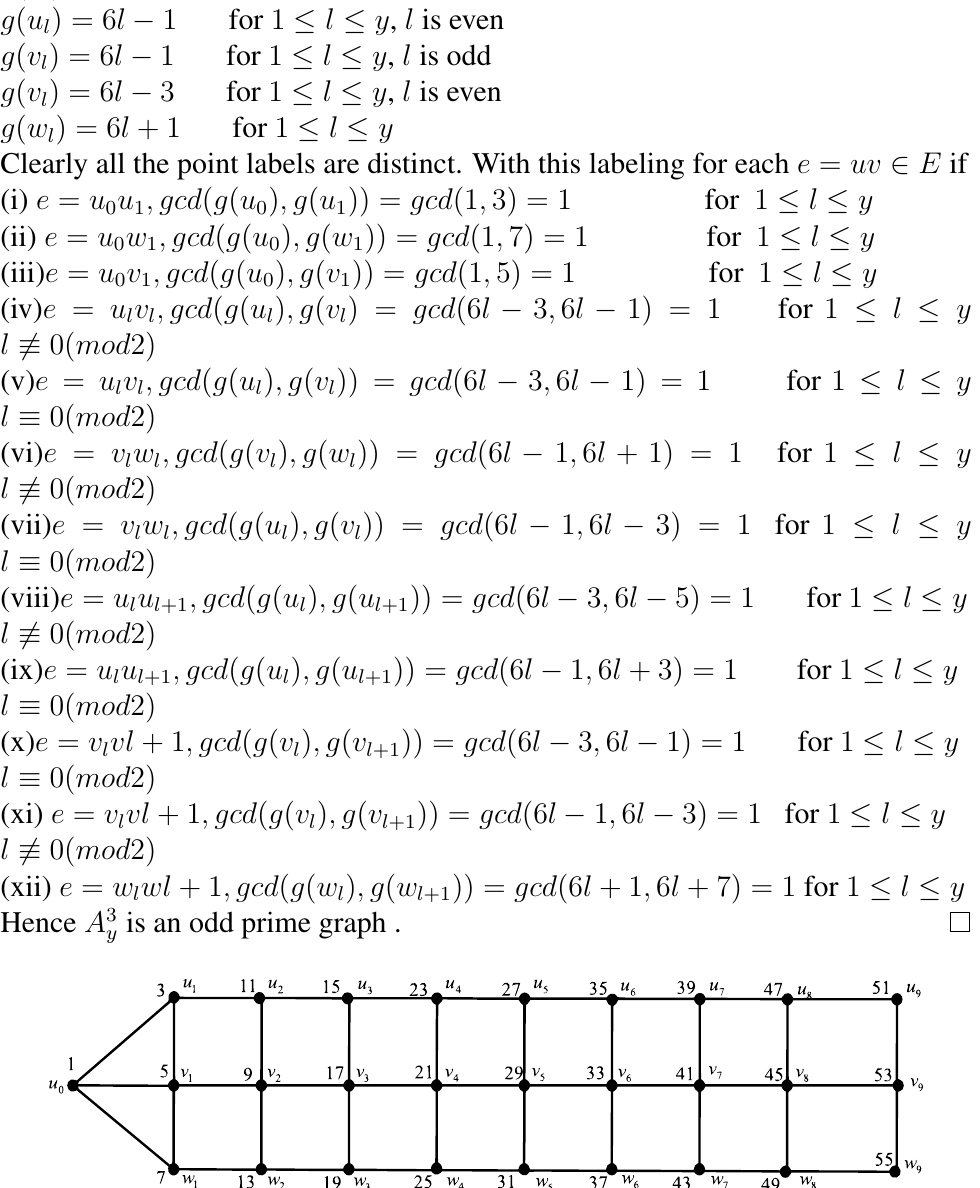
Figure 2: Arrow graph A 3